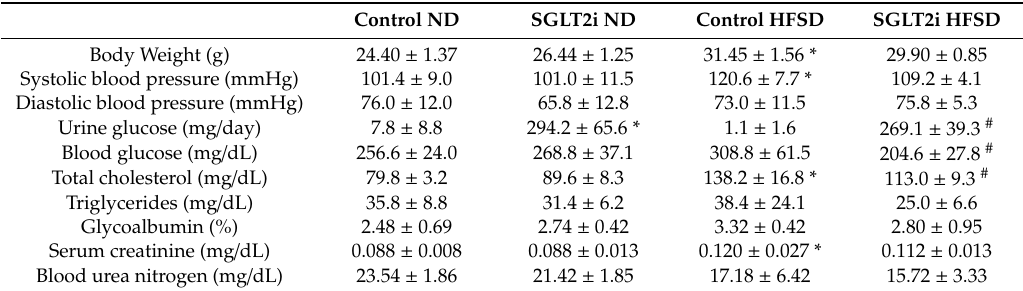
Table 1. Physiological and metabolic parameters in normal diet (ND)-fed group and high-fat and -sugar diet (HFSD)-fed group. Results are presented as the mean ± standard deviation. Di ff erences were evaluated by two-way ANOVA followed by Tukey–Kramer test; * p < 0.05 vs. control ND, # p < 0.05 vs.